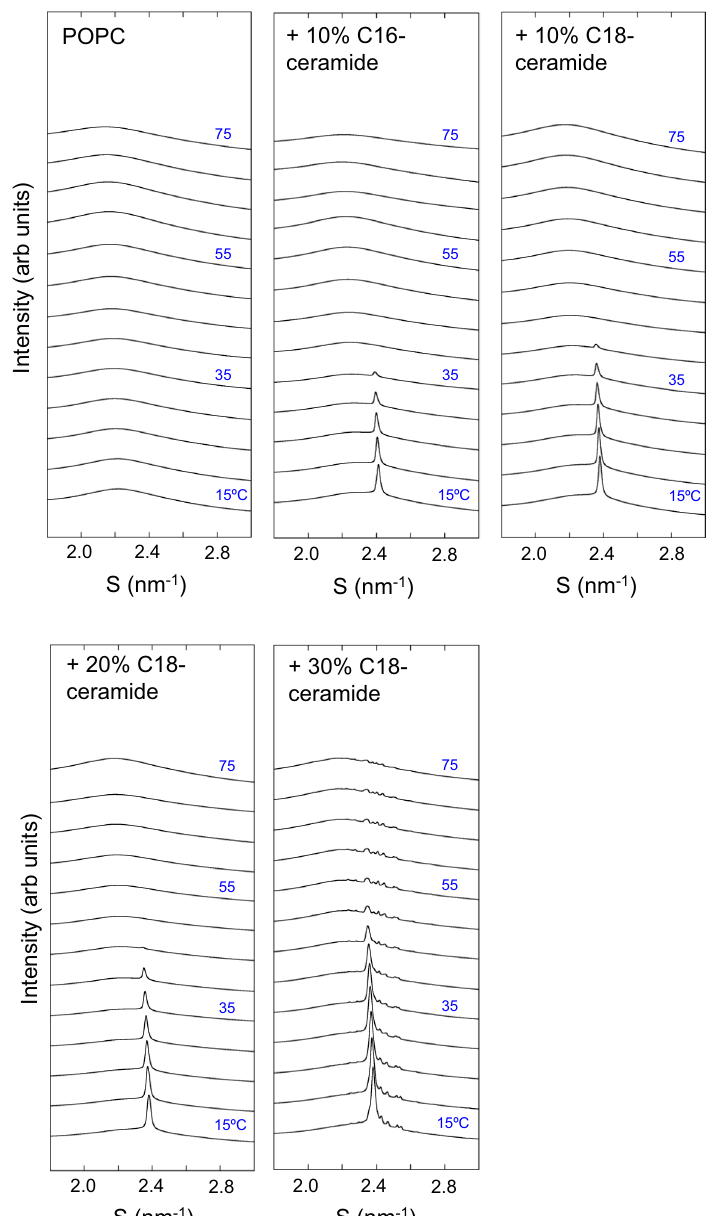
Figure 4. Wide-angle X-ray scattering (WAXS) profiles obtained from POPC, POPC/10% C16-ceramide and POPC/C18-ceramide containing different amounts of C18-ceramide (10, 20, 30 mol%). Data were taken from 15 to 75 °C at 5° interval. All samples (150 mM final lipid concentration) were dispersed in 20 mM HEPES buffer (pH 7.0) containing 100 mM NaCl and 10 mM